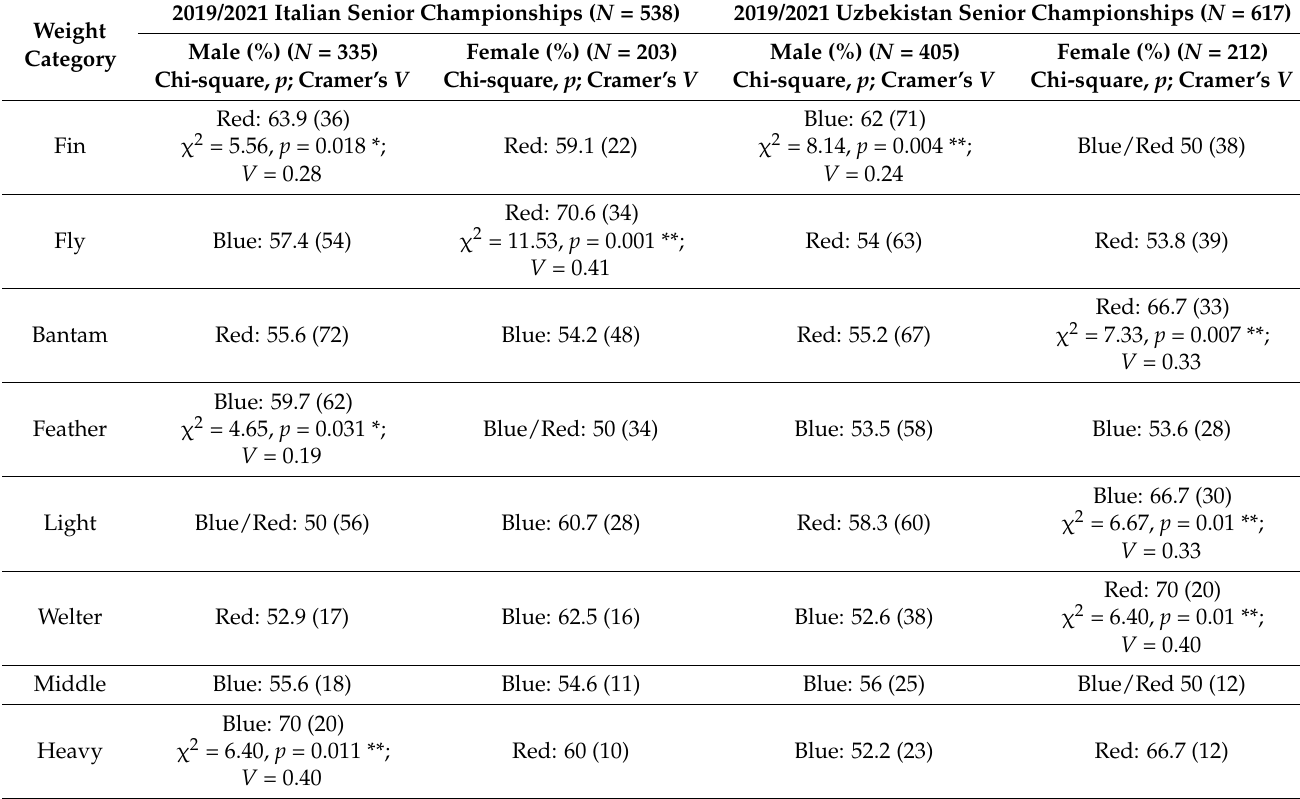
Table 3. Percentage of taekwondo matches won by male and female athletes according to their color of protectors, national context, and weight